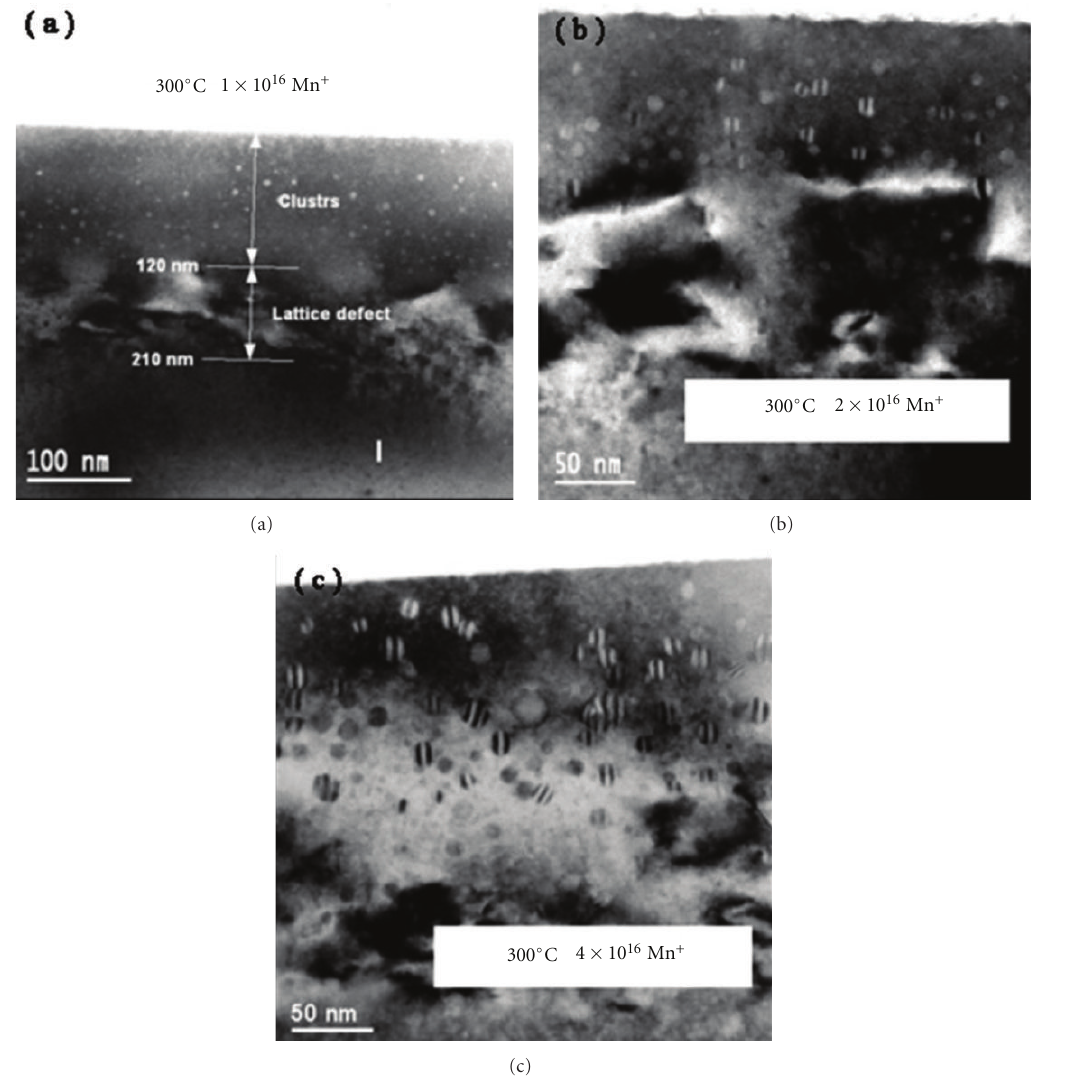
Figure 2: Bright-field cross-sectional TEM images of GeMn samples implanted at various doses (same substrate temperature ( T S ) of 300 ◦ C). Reproduced from [10]. Copyright ©2007, WILEY-VCH Verlag GmbH & Co. KGaA,